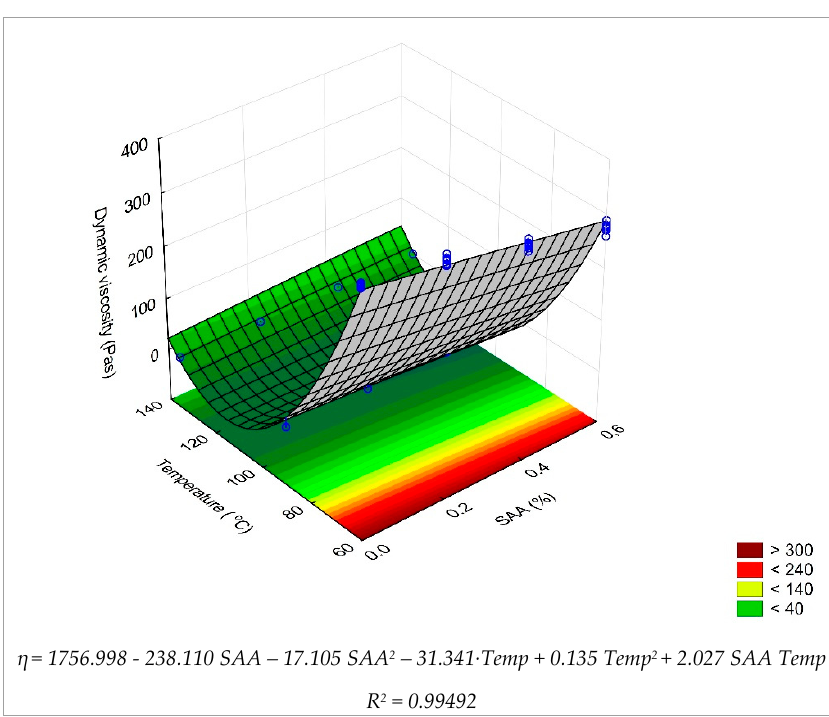
Figure 4. Dynamic viscosity of 50/70 bitumen versus test temperature and SAA content. The provided equation describes the relationship between the SAA content, temperature, and bitumen dynamic viscosity.